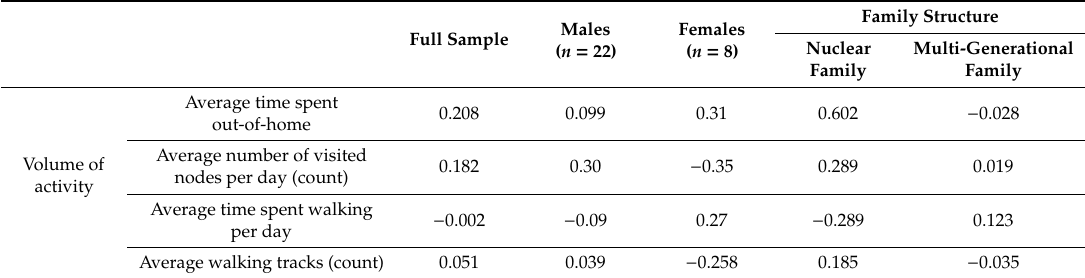
Table 5. Bivariate Correlations (Spearman correlations) between Perceived Health (overall health) and Spatial Activity.